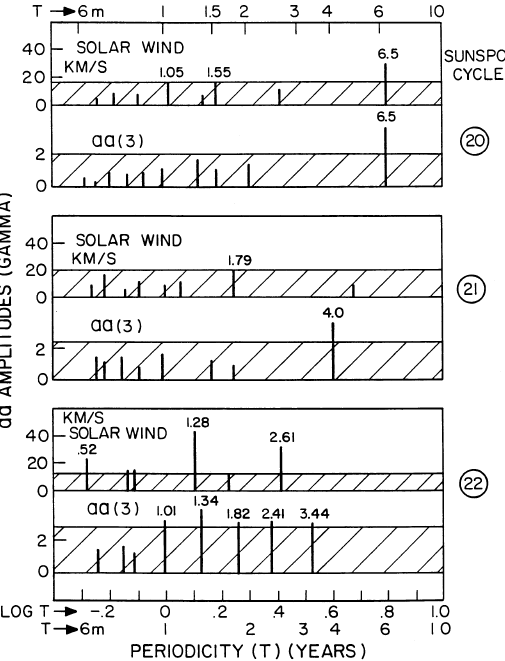
Fig. 8a–f. Spectra for a , b 3-monthly means and c , d 12-monthly means of solar wind and aa indices for 32-y period 1964–1995 (solar cycles 20, 21, 22), e aa (12-39) and f aa(I)